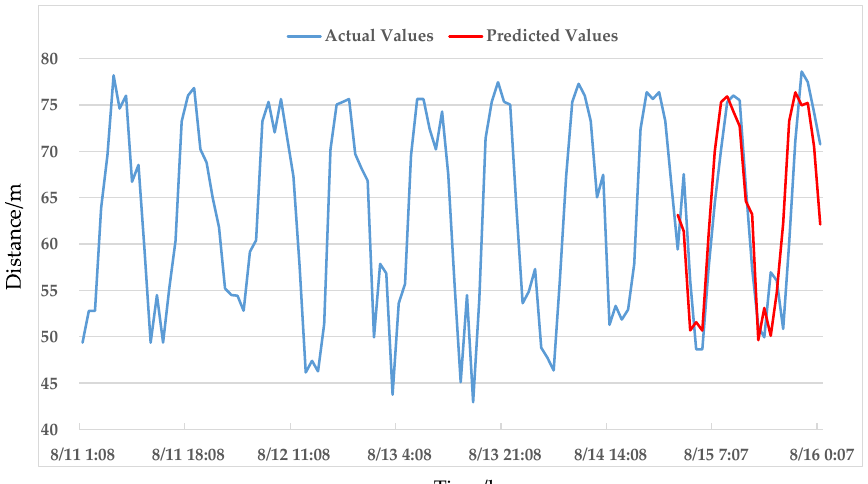
Figure 16. Comparison of offset azimuth prediction.